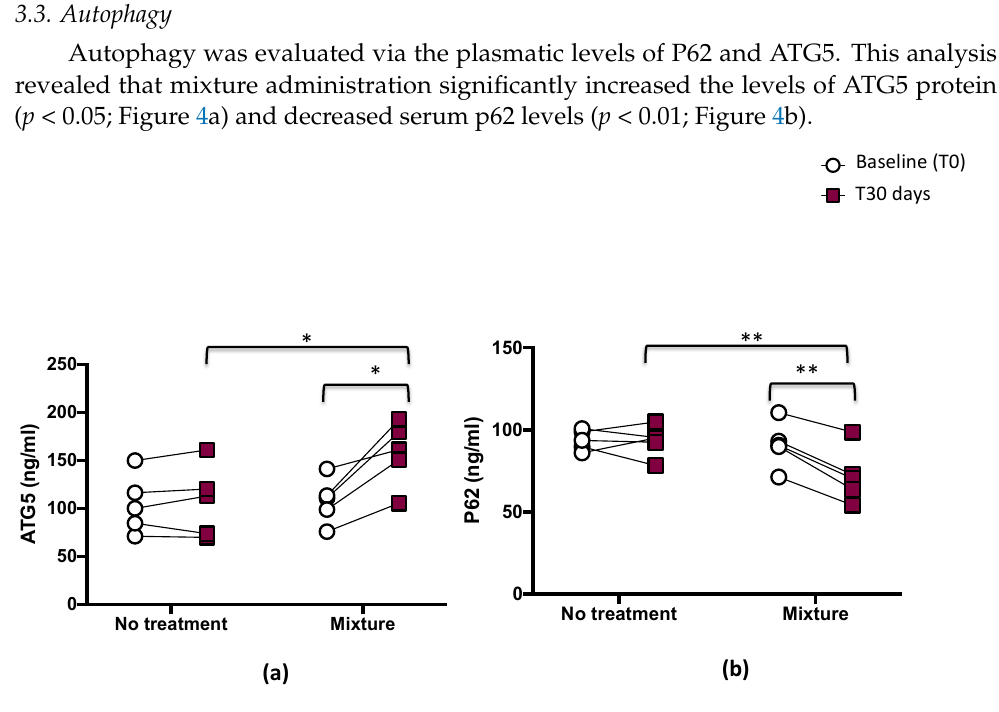
Figure 3. Serum soluble NOX2-derived peptide (sNOX2-dp) ( a ), serum H 2 O 2 ( b ), and blood HBA ( c ) before (T0) and 1 month (T30 days) after mixture intake ( n = 5) or no-treatment period ( n = 5) in athletes. Data are expressed as mean ± SD. * p < 0.05, ** p < 0.01.